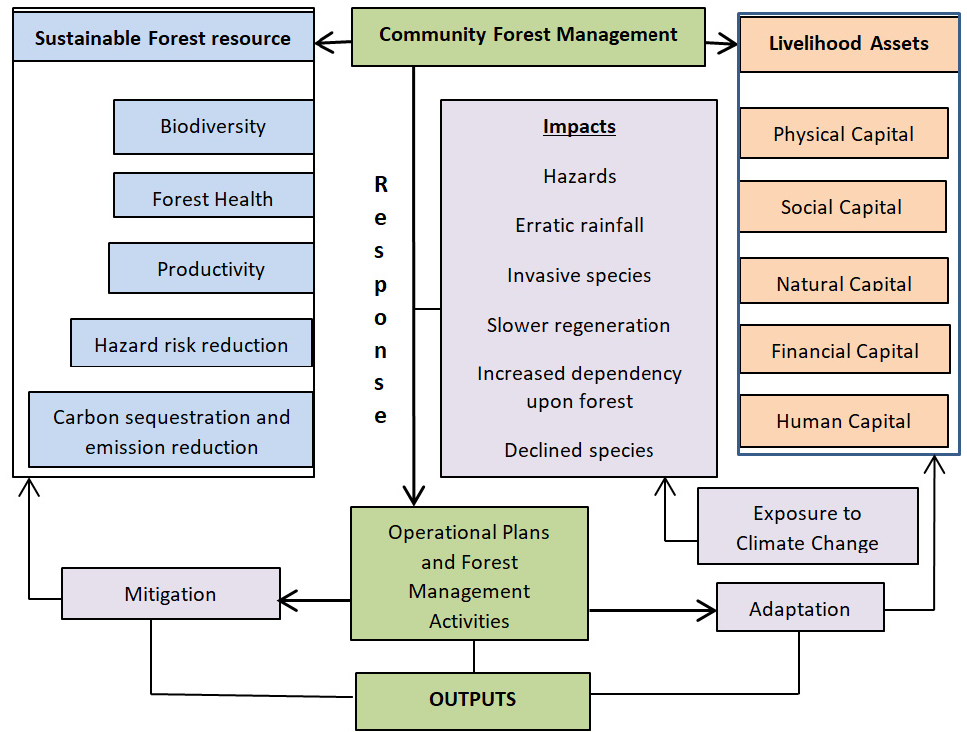
Figure 1. Conceptual framework showing the linkage of community forest management and climate change.